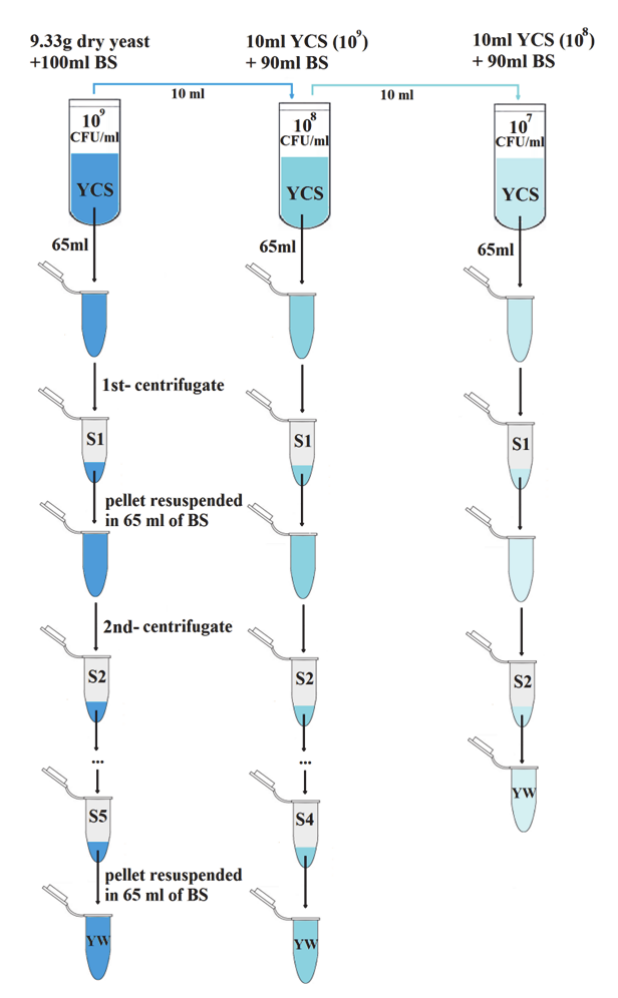
Fig.2: Serial dilution of yeast cell suspension (YCS) and steps to get final suspension of washed yeasts (YW). Sn = supernatants obtained after